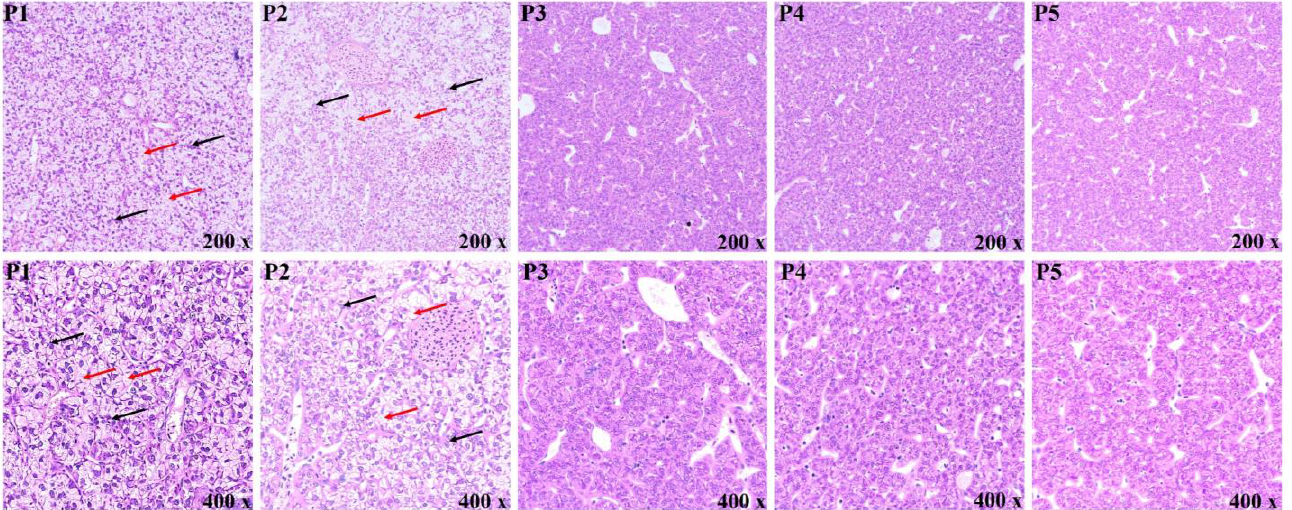
Figure 2. Effect of protein levels on hepatic morphology of Oncorhynchus mykiss . The red arrow indicates hepatocyte vacuolation. The black arrow indicates hepatocyte nuclear migration. Magnification: 200× and 400×.